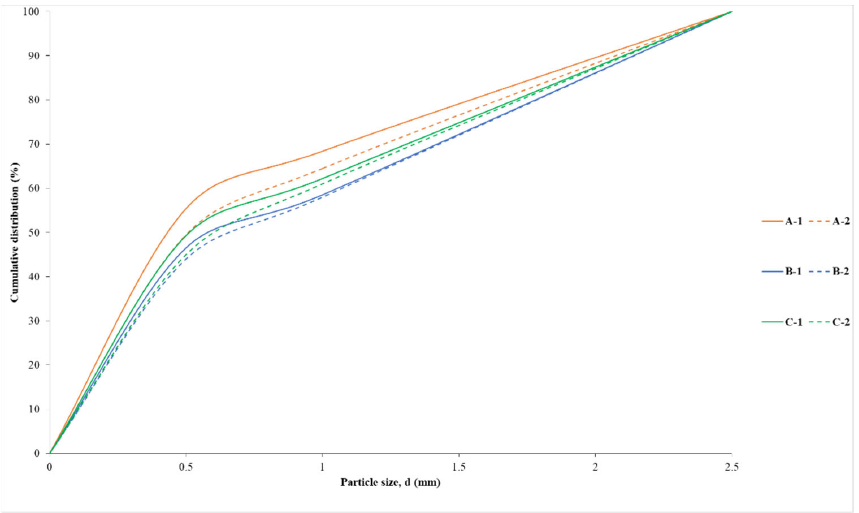
Figure 17. Efficiency of the dry agglomeration processes.